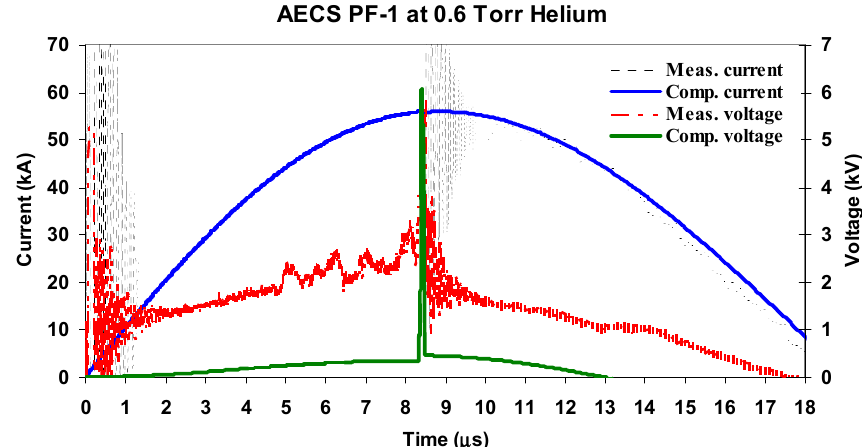
Figure 2. The measured and computed waveforms of the current and voltage in the AECS PF-1 plasma focus device at p 0 = 0.6 Torrofhelium.